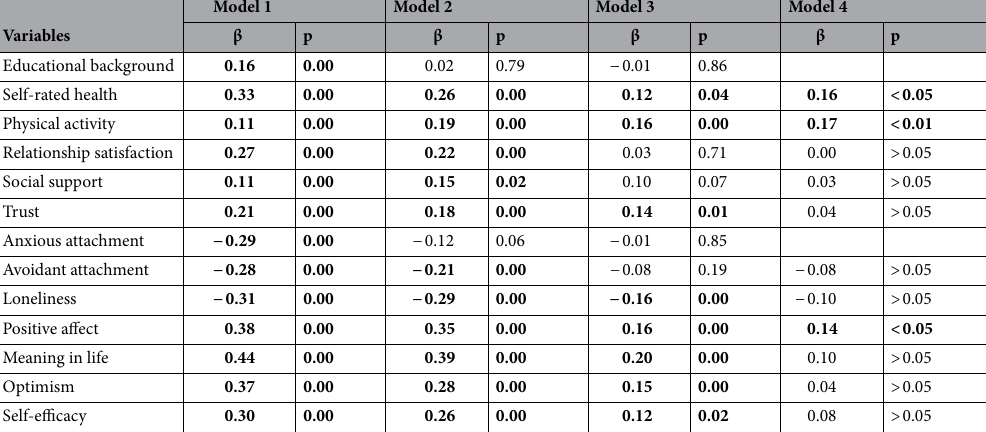
Table 4. Regression analyses for type 1 resilience. Significant effects (p < 0.05) in bold type. N varies between 415 and 888. See Method section and Table 1 for more information. Model 1: Linear model, standardized, with control for sex and age, for each variable separately. Model 2: Linear mixed model, standardized, with control for sex, age and genetic confounding, for each variable separately. Model 3: Linear mixed model, standardized, with control for sex, age, genetic confounding and the other resilience measure, for each variable separately. Model 4: Multivariate linear mixed model, standardized, with control for sex, age and genetic confounding, with all significant variables from Model 2 included.